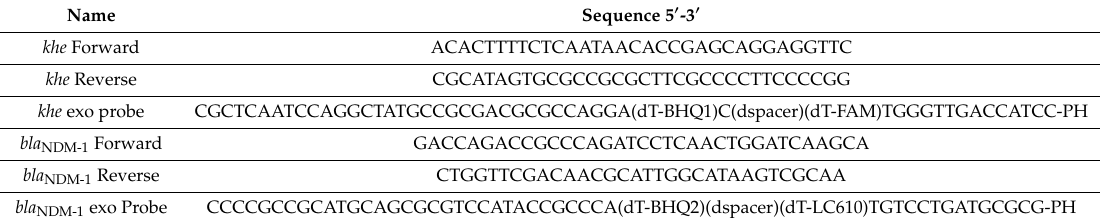
Table 3. RPA primers and exo probes used in this work.